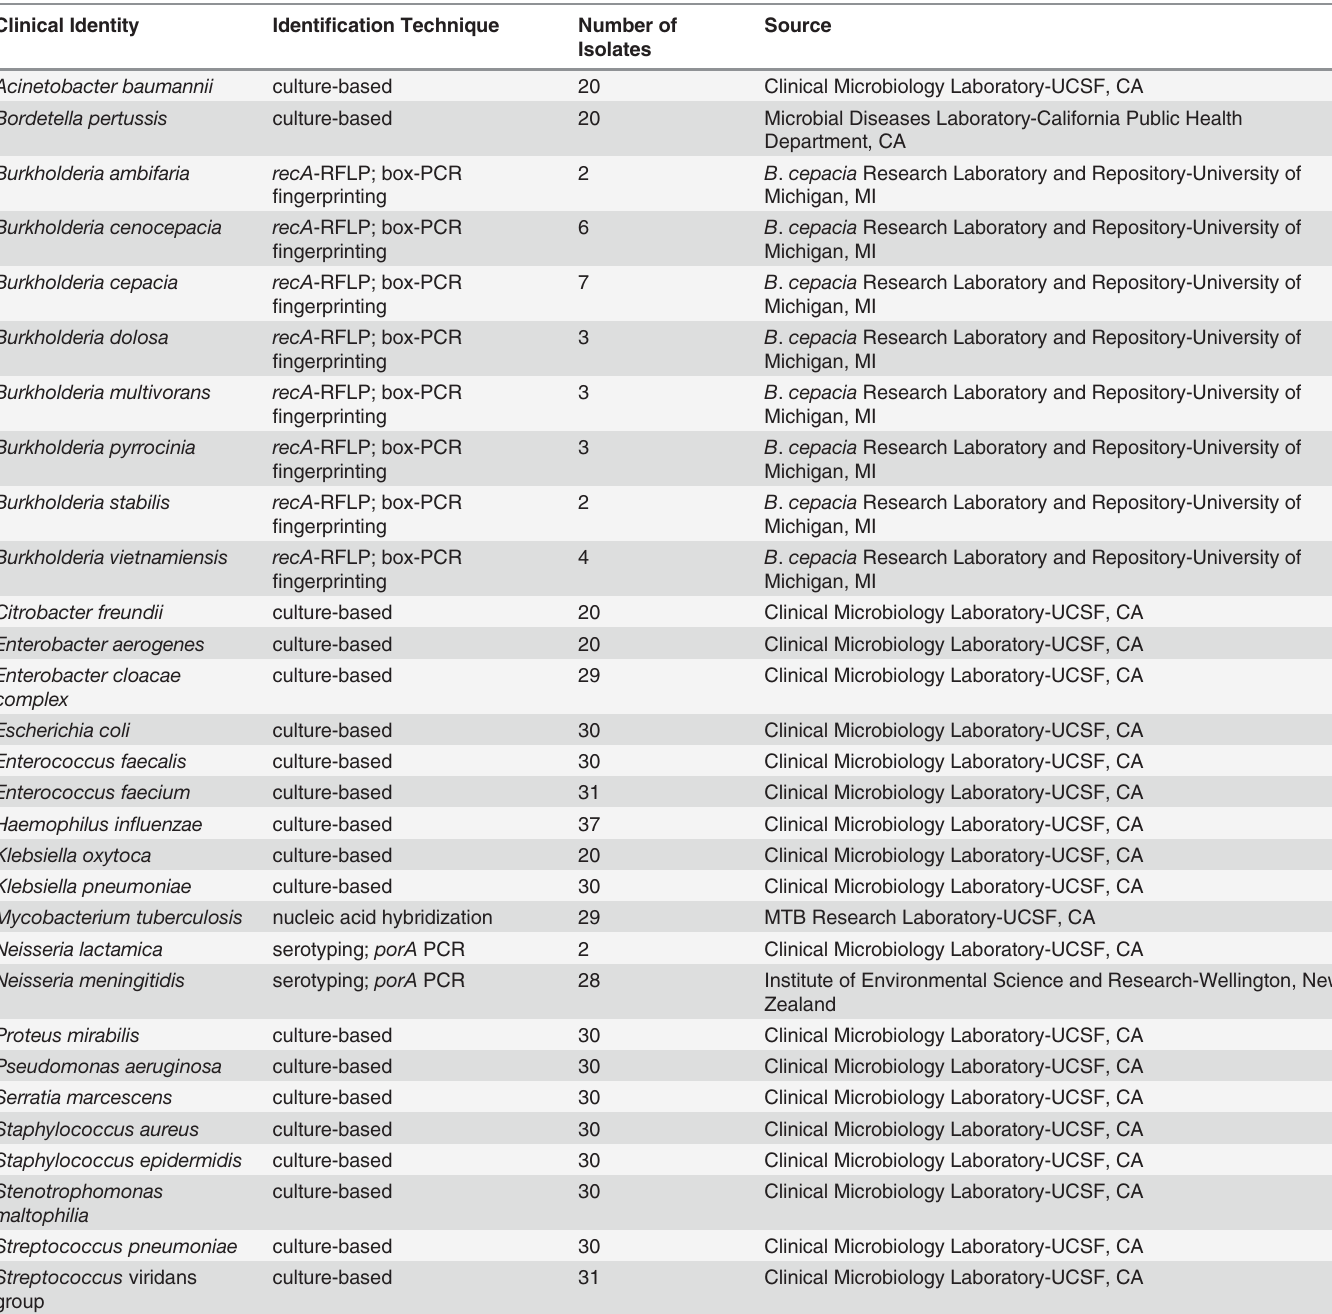
Table 1. Clinical identity, identi fi cation technique, and source of all the clinical isolates used in this study. Clinical